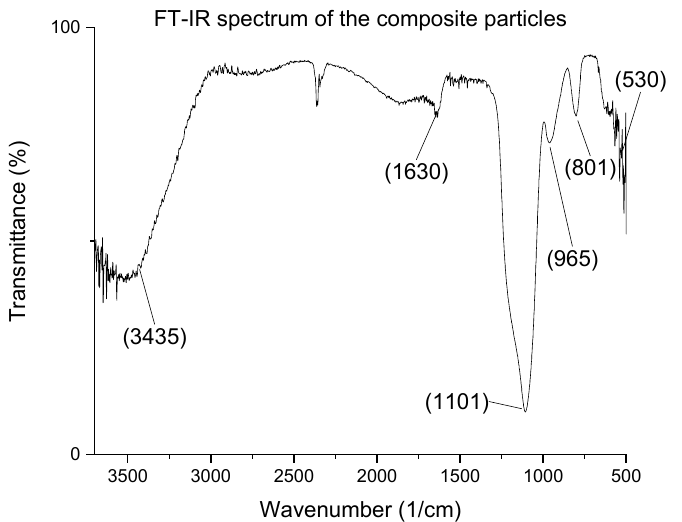
Figure 5. FT-IR spectrum of the composite particles. Table 5. Vibrations of the composite nanoparticles.